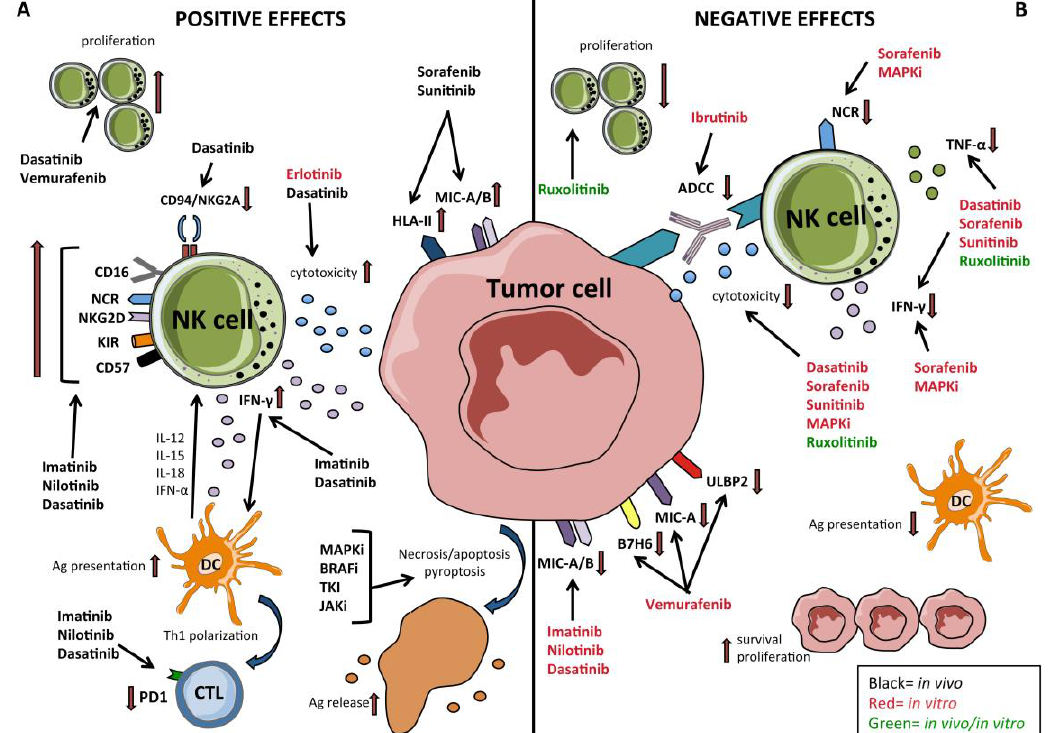
Figure 2 . Effect of targeted therapies (TT) on tumor cells and Natural Killer (NK) cells a ) The positive effects exerted by different TT on both tumor cells and NK cells. Apoptosis/necrosis/pyroptosis of tumor cells induced by TT results in release of tumor antigens for cross-presentation to DCs; In leukemia ibrutinib down-regulates the surface expression of the immune checkpoint ligand (PD-L1) of programmed cell death receptor-1 (PD-1); in leukemia imatinib, nilotinib and dasatinib upregulate the expression of NCR, NKG2D, CD16, and CD57 on NK cells while only dasatinib upregulates the amount of circulating NK cells and downregulates the surface expression of CD94/NKG2A inhibitory receptor on NK cells in vivo ; dasatinib and imatinib enhance IFN- γ release while dasatinib also enhances NK cell cytotoxic activity. MEKi and BRAF inhibition of BRAF V600E melanoma cells inhibit the secretion of immunosuppressive cytokines (VEGF, IL-6, and IL-10); in solid tumors sorafenib and sunitinib up-regulate the surface expression of HLA class II molecules and NKG2DL (MIC-A/B) in vivo . Erlotinib enhances NK cell cytotoxicity in vitro . Vemurafenib upregulates the amount of circulating NK cells in vivo . b ) The “unwanted” effects exerted by different TT on both tumor cells and NK cells. In leukemia, imatinib, nilotinib and dasatinib downregulate the surface expression of NKG2DL (MIC-A/B) and upregulate the expression of KIRs on NK cells; in leukemia, ibrutinib exerts a negative effect on NK cell-mediated ADCC. In BRAF-mutated melanoma vemurafenib downregulates the expression of B7-H6 (NKp30L) and MIC-A (NKG2DL). MAPKi and sorafenib down-regulates NCR expression on NK cells; MAPKi, sorafenib, and sunitinib hamper NK cell function (cytoxicity, IFN γ -release); in leukemia; in MPN, ruxolitinib hinders NK cell proliferation and function (cytotoxicity and cytokine